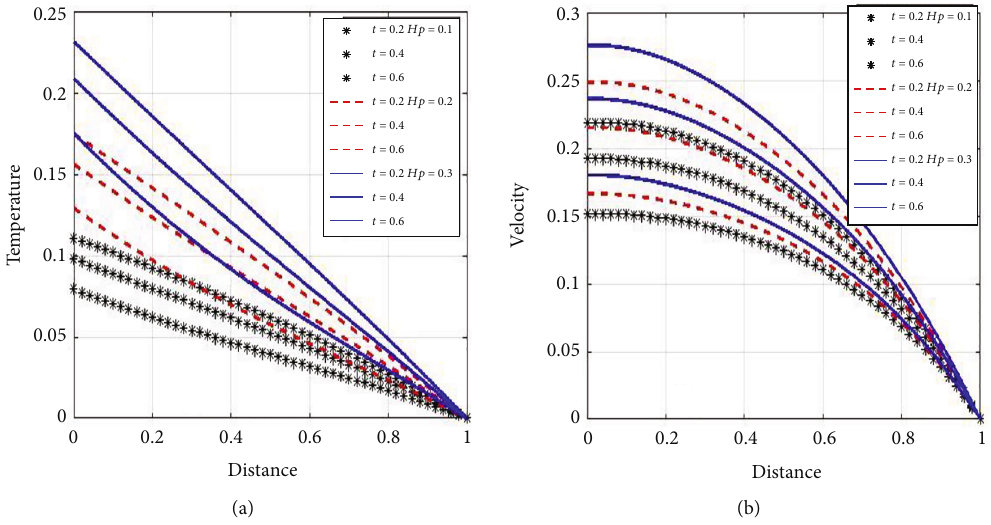
Figure 5: Temperature and velocity in an unsteady state for Hp